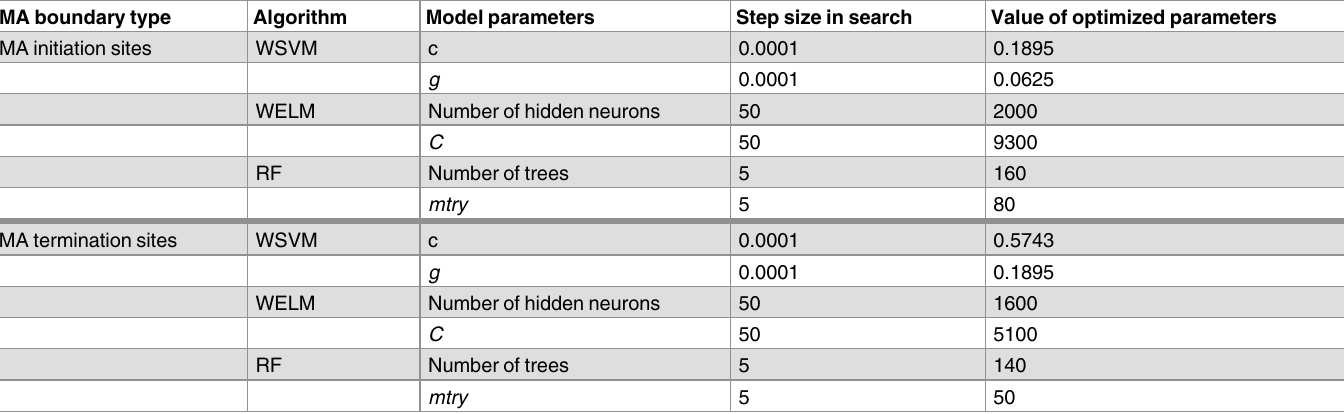
Table 2. Optimization details of parameters in WSVM, WELM, RF models.